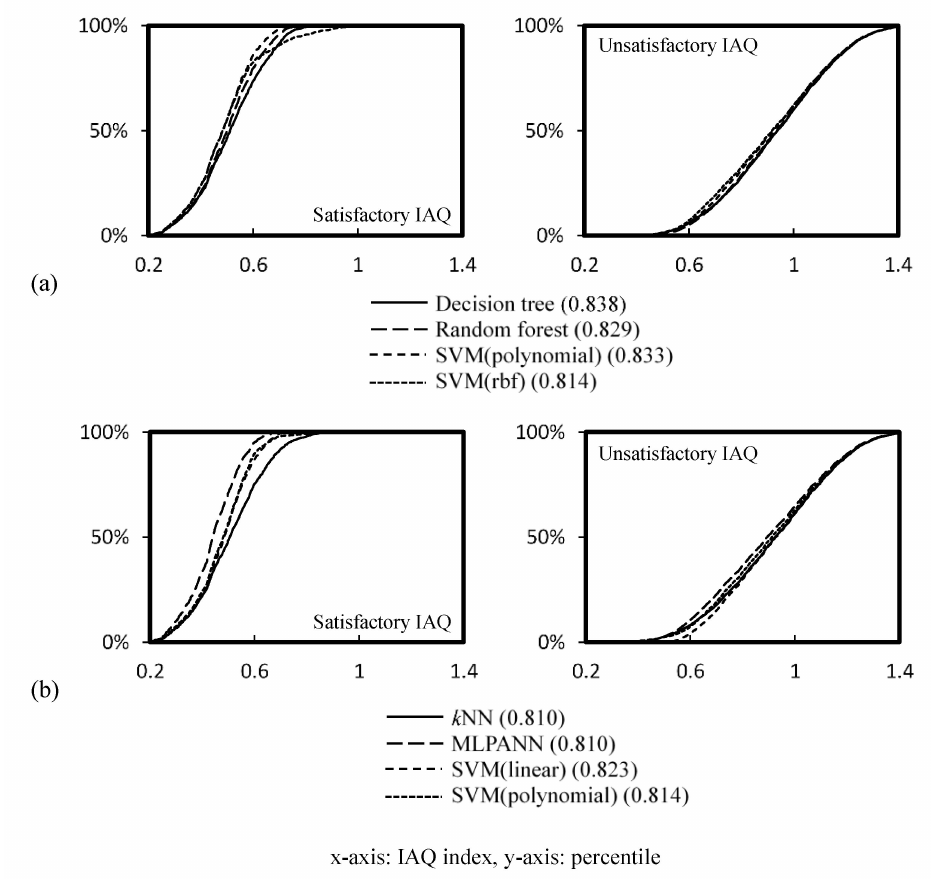
Figure 9. Predicted IAQ satisfaction and dissatisfaction with an IAQ index with assessment criteria, ( a ) Scheme 1, ( b ) Scheme